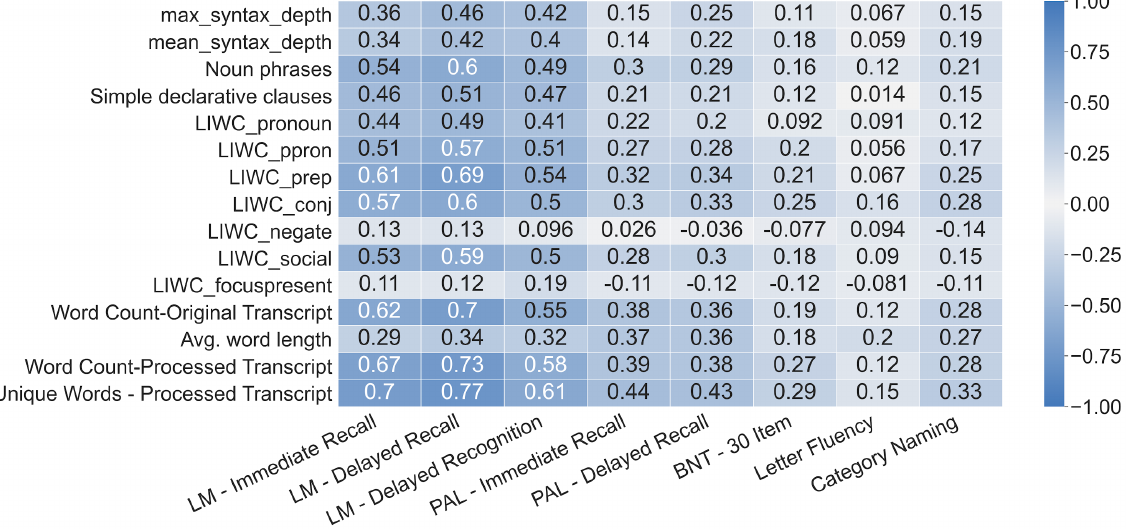
Figure 5. Pearson correlations between the top 15 most contributing features from the expanded linguistic feature set and the language-based